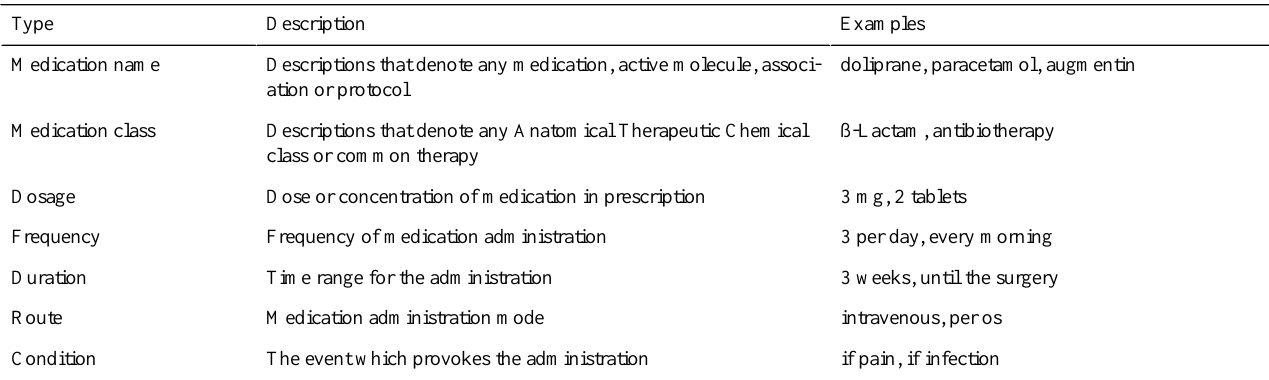
Table 1. Description of the